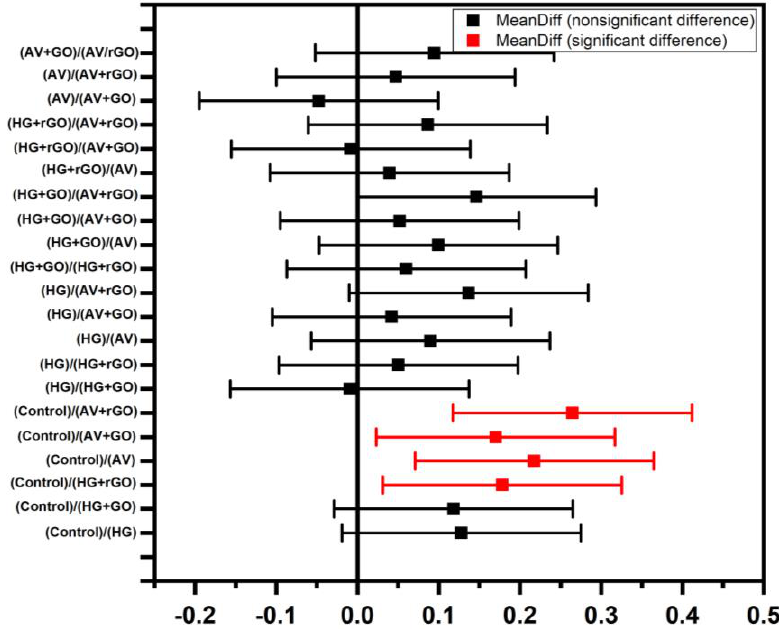
Figure 19. Statistical significance among experimental data using one-way ANNOVA ( p < 0.5 and p < 0.1).